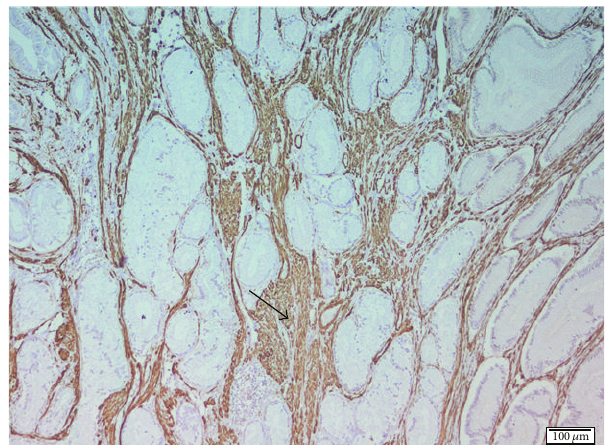
Figure 4: Immunohistochemistry showing hyperplastic cells with diffuse and strong positivity with smooth muscle actin (SMA) (arrow), while the gastric glands epithelium was negative. Immunoperoxidase-diaminobenzidine stain, Mayer hematoxylin counterstain. Bar = 100 𝜇